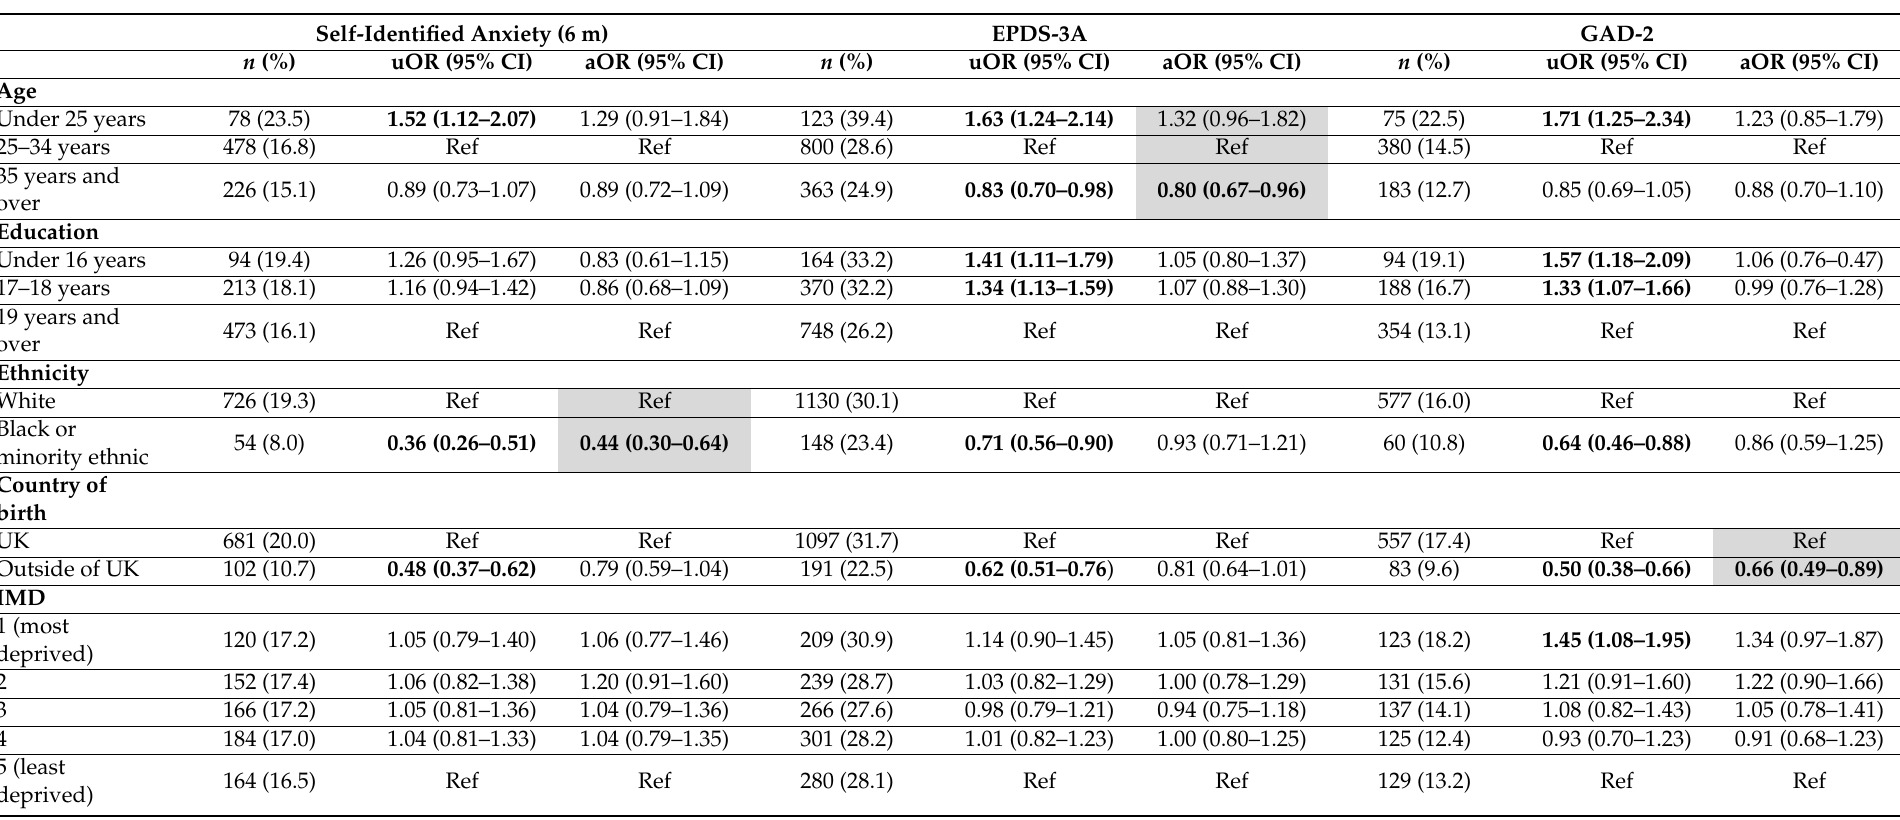
Table 5. Unadjusted and adjusted odds ratios of associations between participant characteristics and anxiety according to different